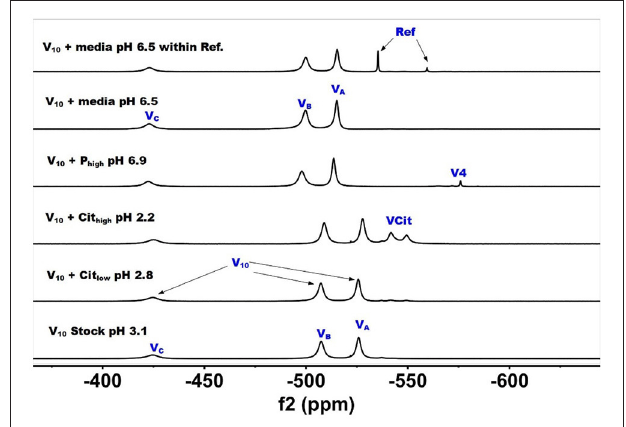
FIGURE 2 | 51 V NMR (78.9 MHz) spectra are shown of solution of decavanadate (10mM V 10 , 100mM V-atoms). The samples are from the bottom up diluted V 10 stock solution (100mM V-atom) at pH 3.1; 10mM V 10 in the presence of 0.48mM and 0.97mM citrate at pH 2.8 and 2.2, respectively; 10mM V 10 in the presence of 24mM P i at pH 6.9; and finally 10mM V 10 in the presence of Middlebrook 7H9 broth medium supplemented with 10% ADC enrichment (5% BSA, 2% dextrose, 5% catalase), glycerol (0.2%, v/v) and Tween 80 (0.05%, v/v) recorded both in the absence and the presence of a capillary reference of 100mM Na 3 VO 4 .